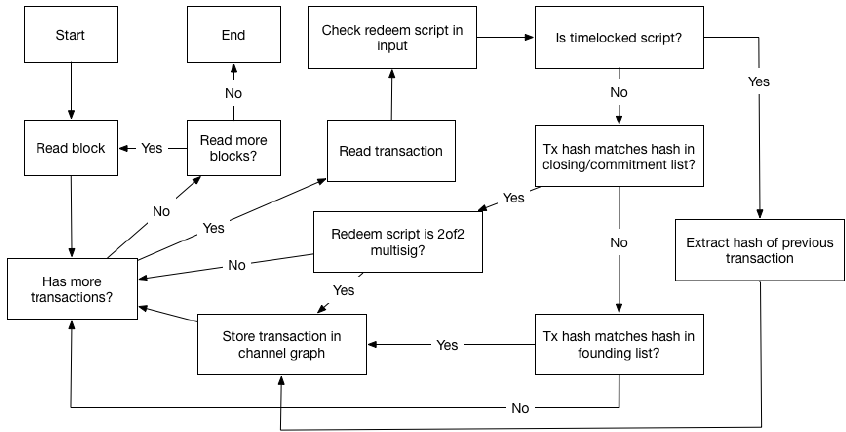
Figure 7. Algorithm for parsing blockchain and creating channel graphs using the timelocked